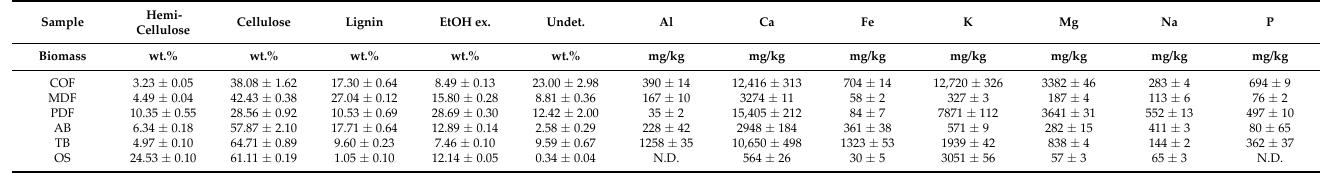
Table 2. Physicochemical characteristics of the biomass streams. EtOH ex. = ethanol extractables, Undet. = undetermined, N.D. = not detected. Error on proximate analysis was assumed to be